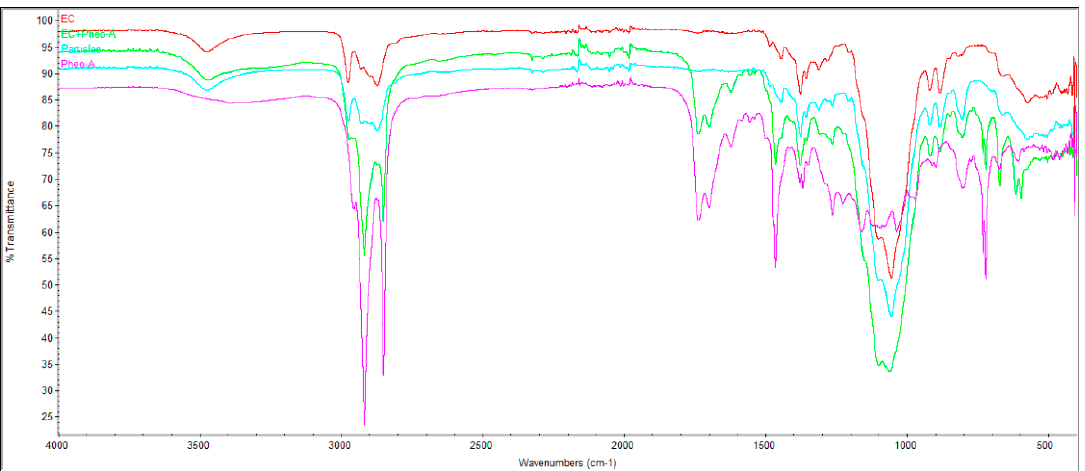
Figure 3. Infrared fourier transform spectroscopy analysis (FTIR) spectra using attenuated total reflectance method at room temperature. From top to bottom: EC, EC + Pheo-a, the formulated EC-pheo-a, and physical mixture of EC & pheo-a.